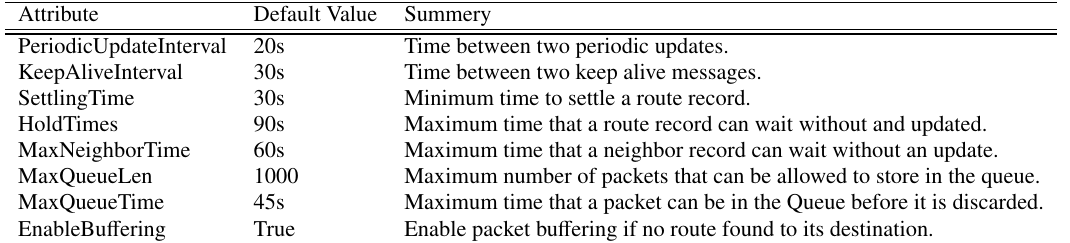
Table 1: DVRP Attributes and default Values